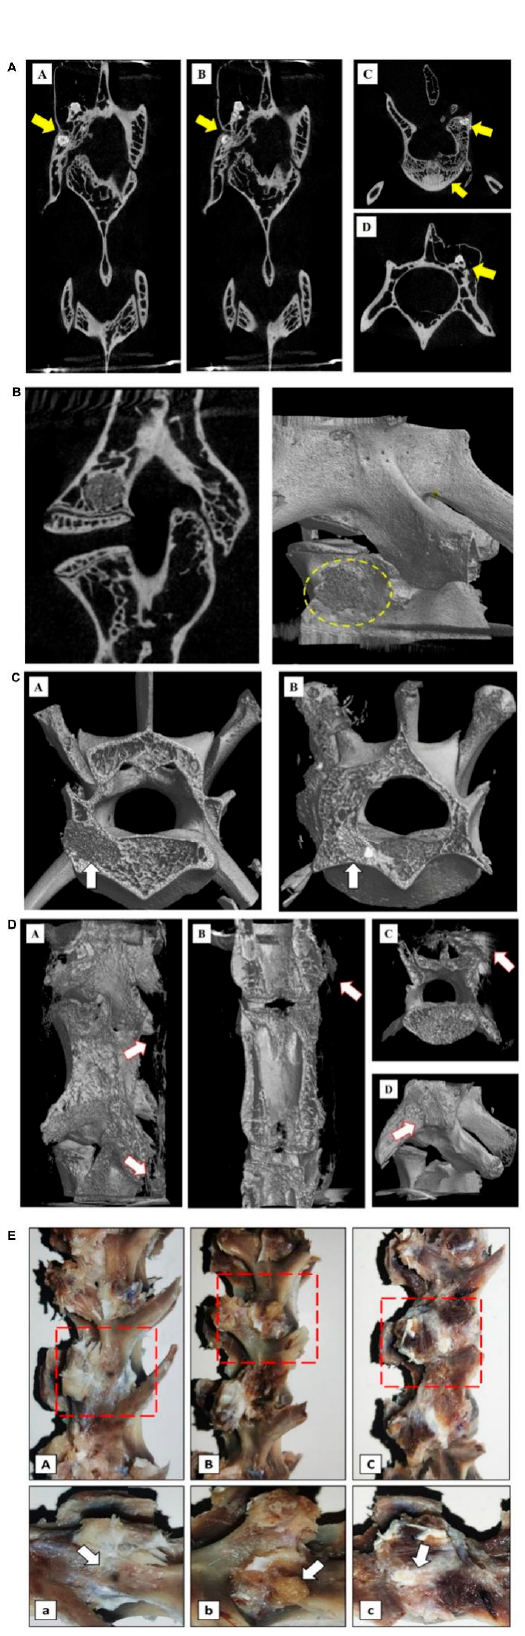
Figure 2. Postoperative imaging examination of PLGA-PEG-PLGA/CPC composite bone cement in the treatment of osteoporosis in rabbit vertebroplasty: ( A ) results of the vertebral body and